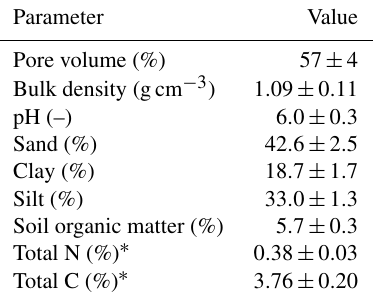
Table 1. Near-surface soil parameters (5–10cm depth) averaged over four locations on the pasture. The measurements are given as mean ± 1 standard deviation.